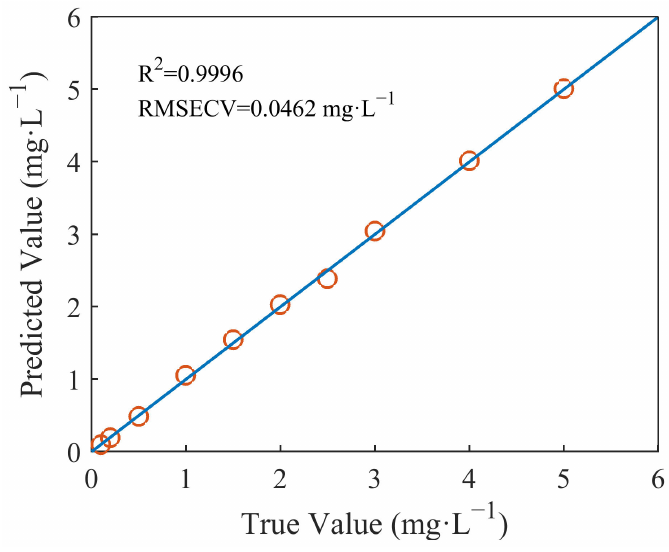
Figure 6. Relationship between the true values and the values of nitrate predicted by